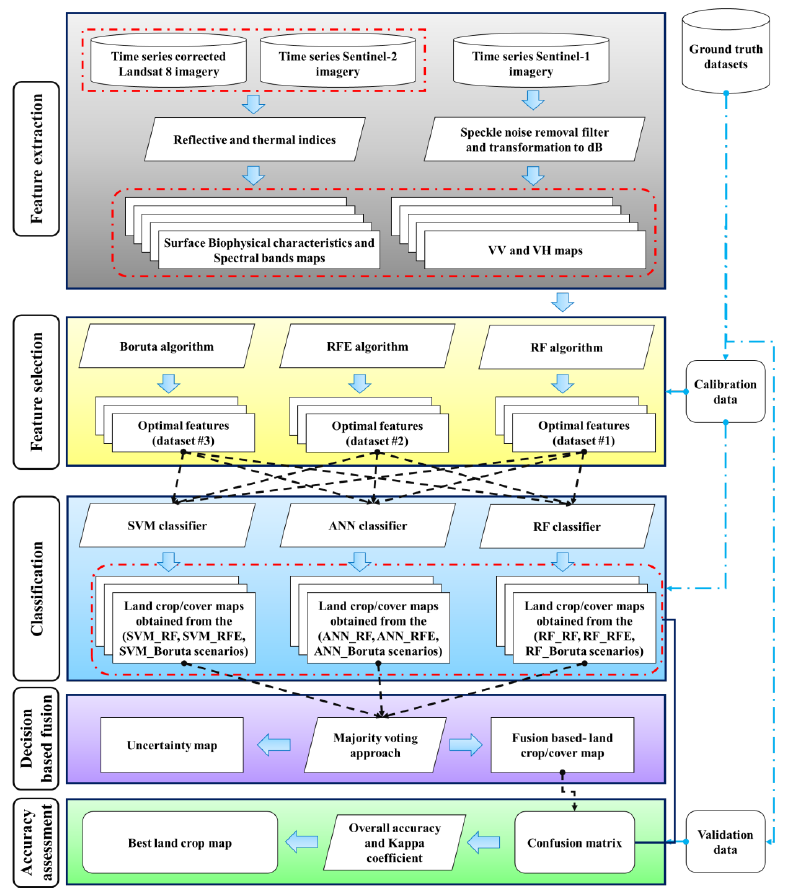
Figure 2. Flowchart of study .